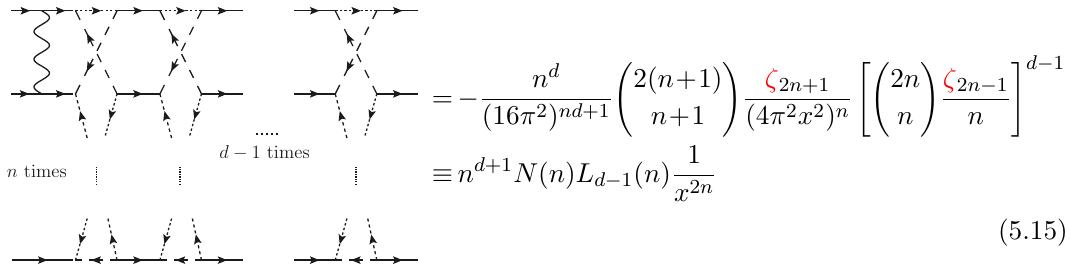
Figure 9. Leading and Next-to-Leading Orders for G ( q, 1 ,d +1) correcting all the adjoint legs with the vector